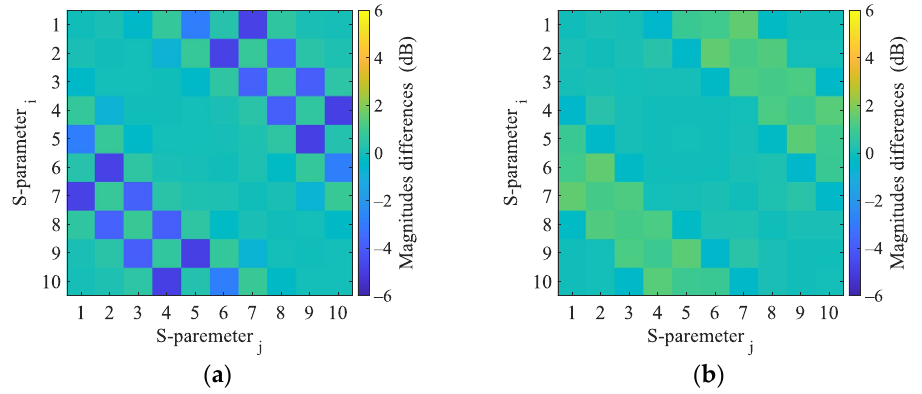
Figure A6. 2D numerical simulations. Magnitudes difference of 2D numerical model induced by the virtual presence of a 4 cm radius ( a ) hemorrhagic and ( b ) ischemic stroke located at position (0, 0).